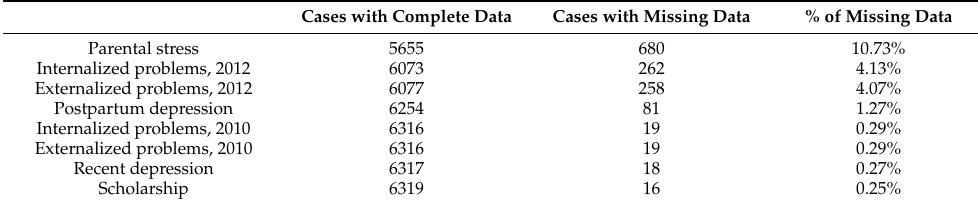
Table 2. Number of missing cases per